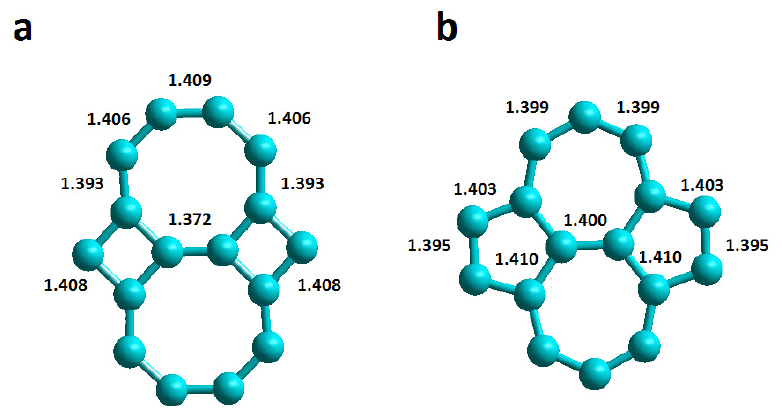
Figure 1. Representation of carbon nanotube structural defects and their C–C bond distances in Å. ( a ) haeckelite defect; ( b ) Stone–Wales defect.